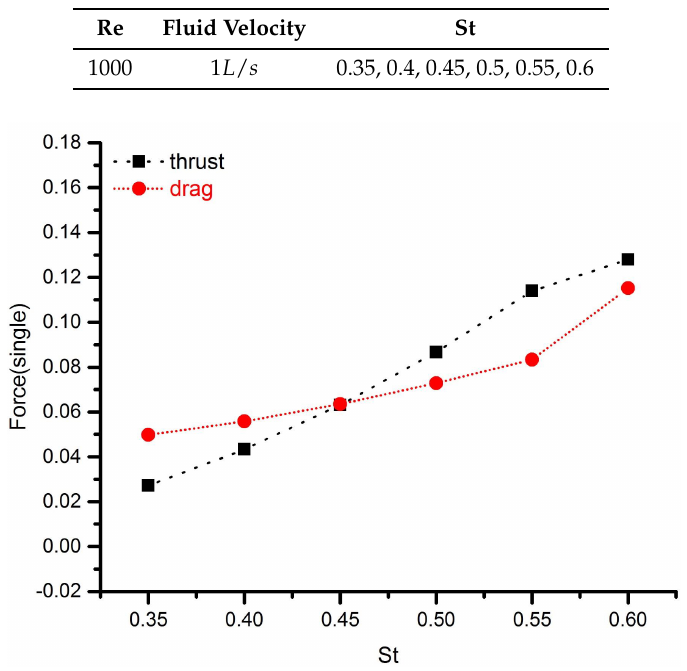
Table 1. The St number in the single fish test.